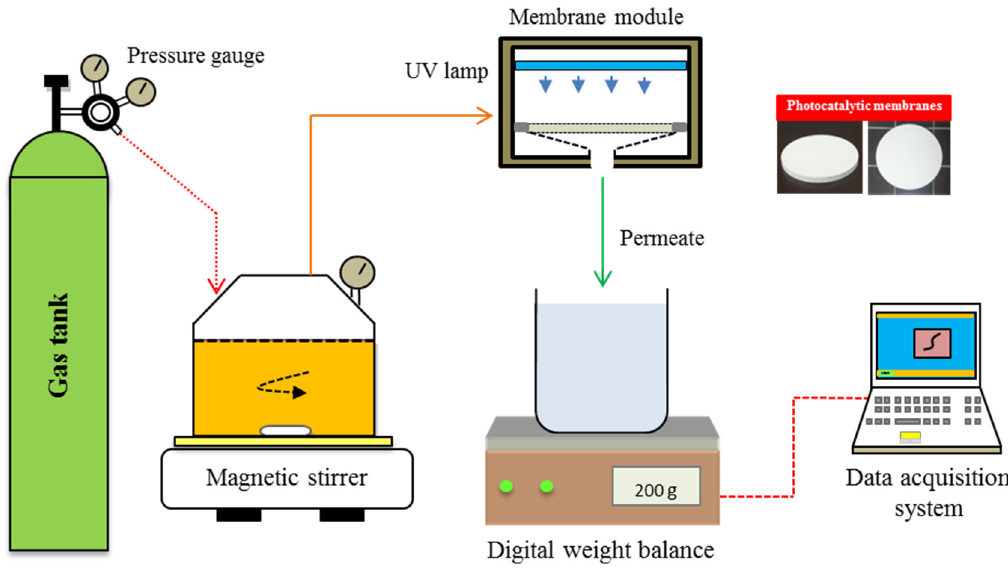
Figure 1. Experimental setup of the photocatalytic membrane reactor (PMR) with direct ultraviolet (UV) irradiation on membrane surface.